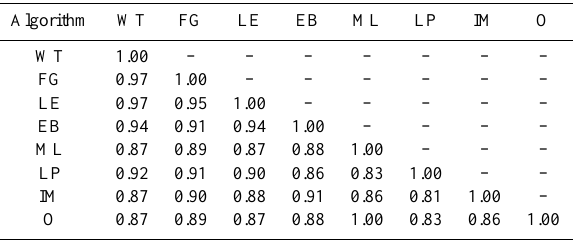
Table 2. Summary of the community analysis. The communities were found using the edge betweenness algorithm (Girvan and Newman, 2002; Newman and Girvan, 2004).